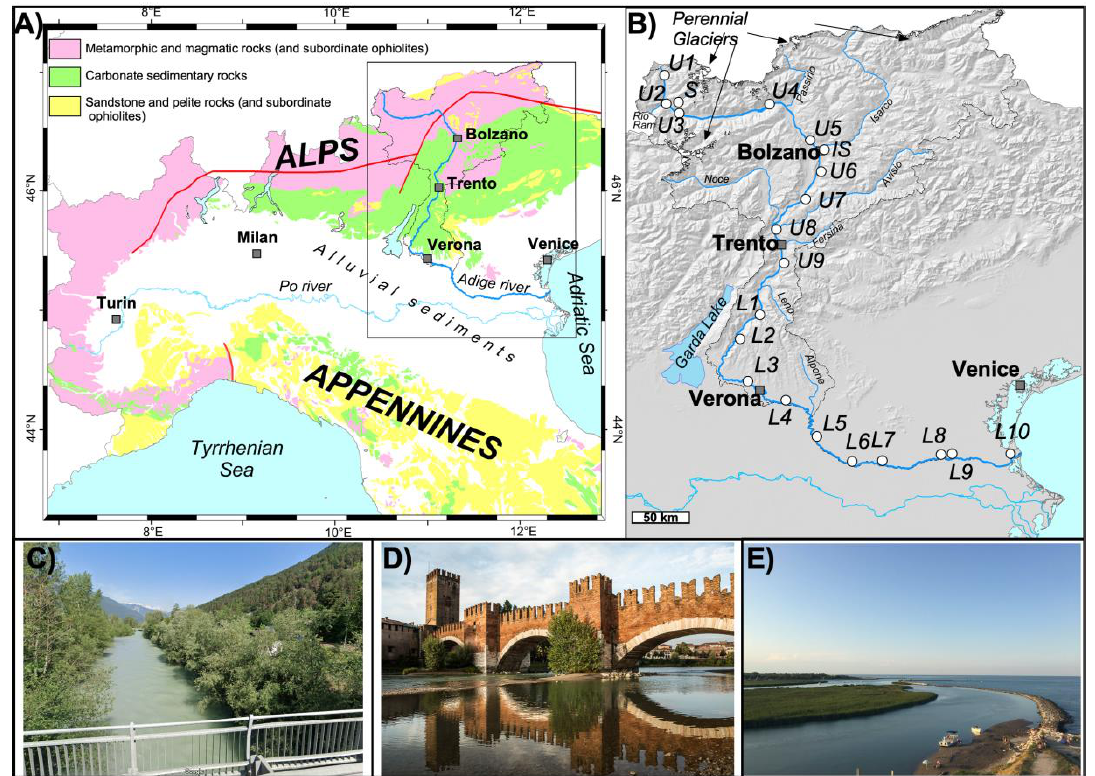
Figure 1. ( A ) Geological sketch map of northern Italy, modified by Natali et al. [18]; ( B ) Adige river catchment with sampling locations; ( C ) Adige river at Spondigna (BZ); ( D ) Adige river at Verona; ( E ) Adige river mouth at Rosolina.